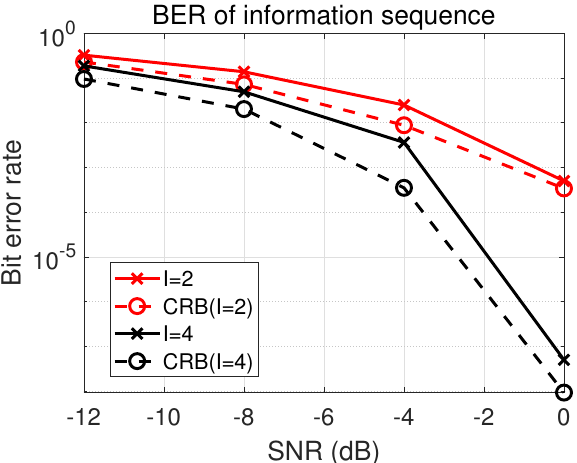
Figure 9. Comparison of BER and CRB ( L = 63, G = 30, R = 3, M =